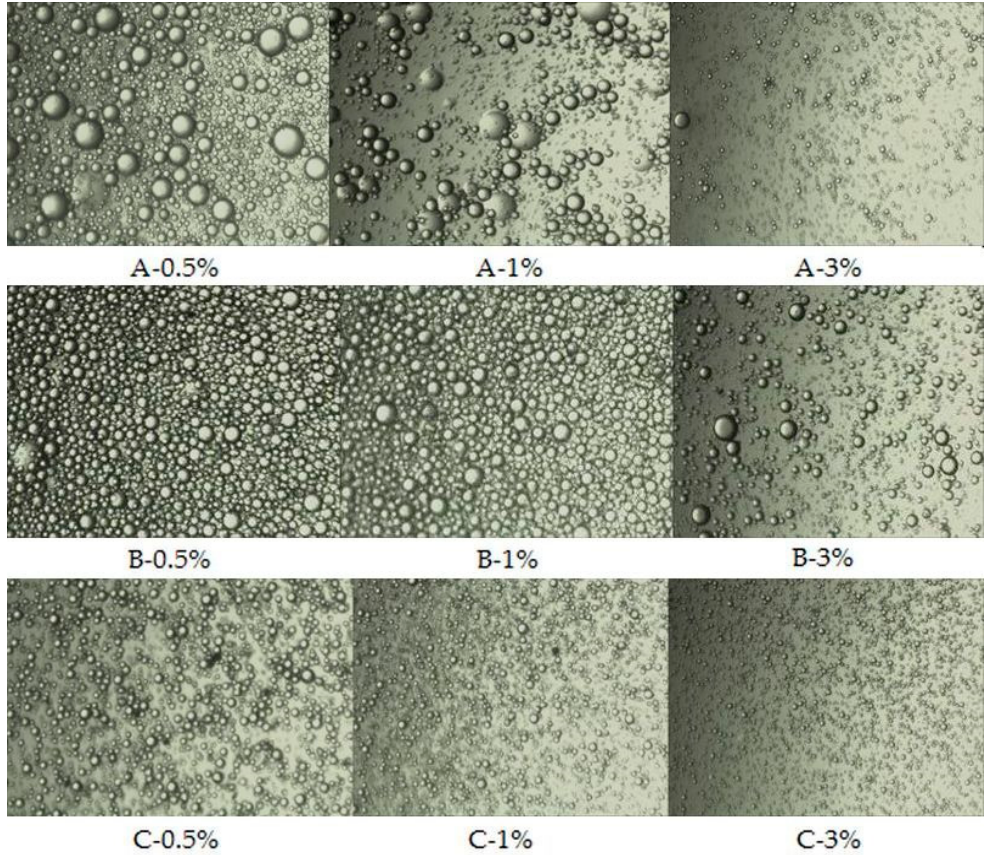
Figure 4. Optical microscopic images of emulsions prepared with FOCE powders obtained at various temperatures; A—emulsions prepared with powder obtained at 160 °C; B—emulsions prepared with powder obtained at 180 °C; C—emulsions prepared with powder obtained at 200 °C; and 0.5%, 1%, and 3%—powder